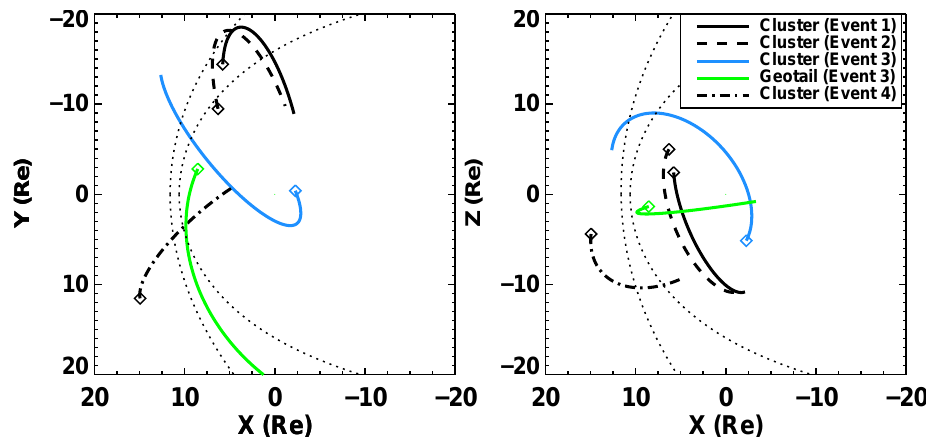
Figure 1. Orbits of the spacecraft during the four studied events in the GSE x – y (left panel) and x – z (right panel) planes. The diamonds indicate the location of the spacecraft at the beginning of the event. The black dotted lines indicate the position of the Jeˇráb et al. (2005) bow shock model and of the Shue et al. (1998) magnetopause model for typical solar wind conditions ( n = 6cm − 3 , V = 400kms − 1 , B = 5nT, B z =